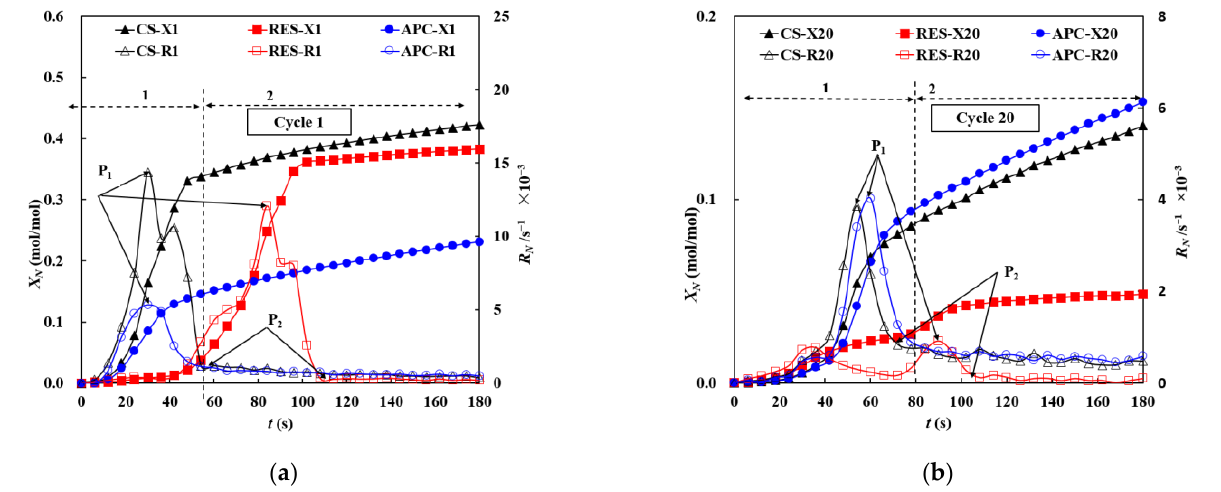
Figure 9. Influence of reaction time on the cyclic CO 2 capture characteristics of calcium-based sorbents: ( a ) relationship between X N and N; ( b ) relationship between R N and N.